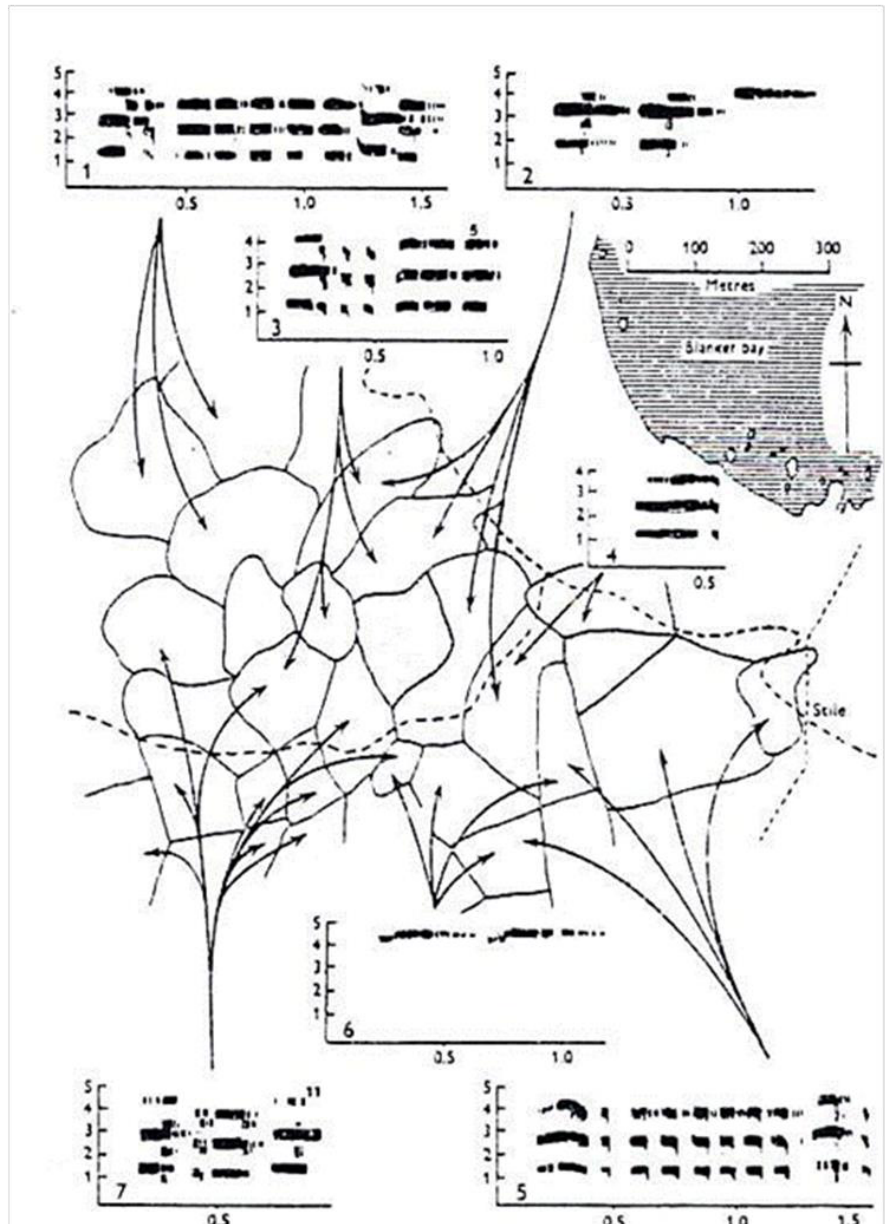
Figure 1. Microgeographical variations in Calladeidae. Territories and sonograms produced by different individuals are represented (Jenkins,